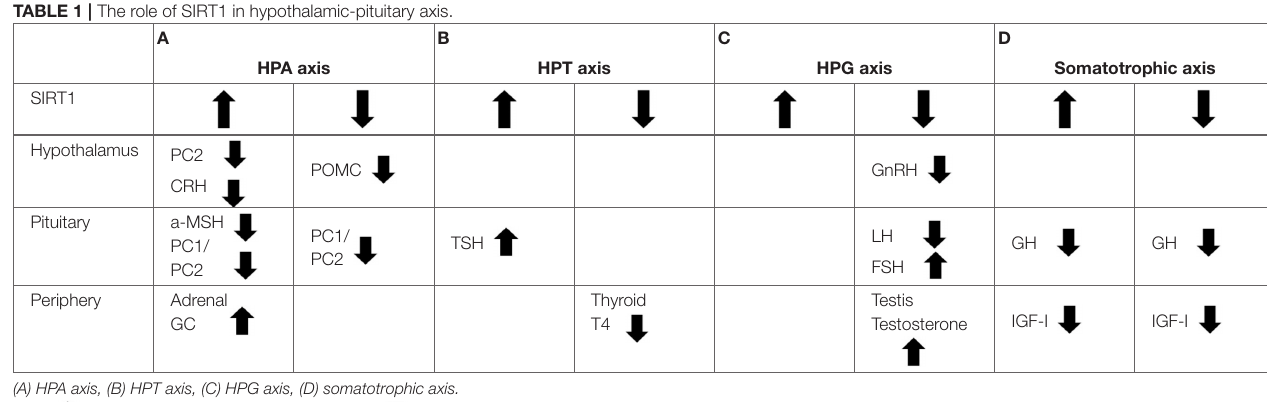
SIRT1 , Overexpression/activation of SIRT1. SIRT1 , Knockout/inhibition of SIRT1. GC, Glucocorticoid, T4, Thyroxine.